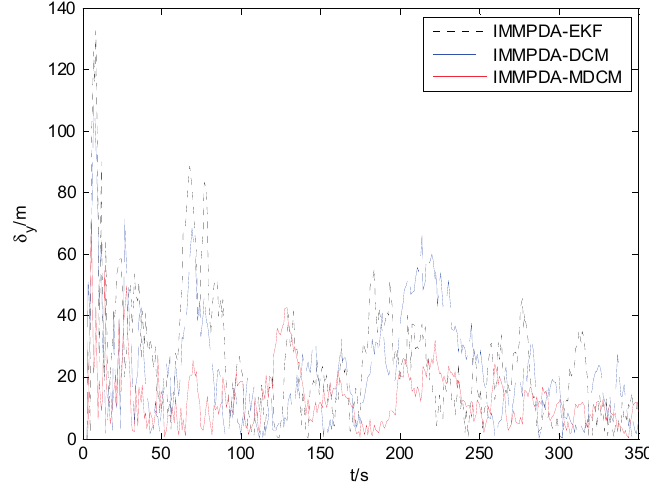
Figure 7. The comparison of position error in y